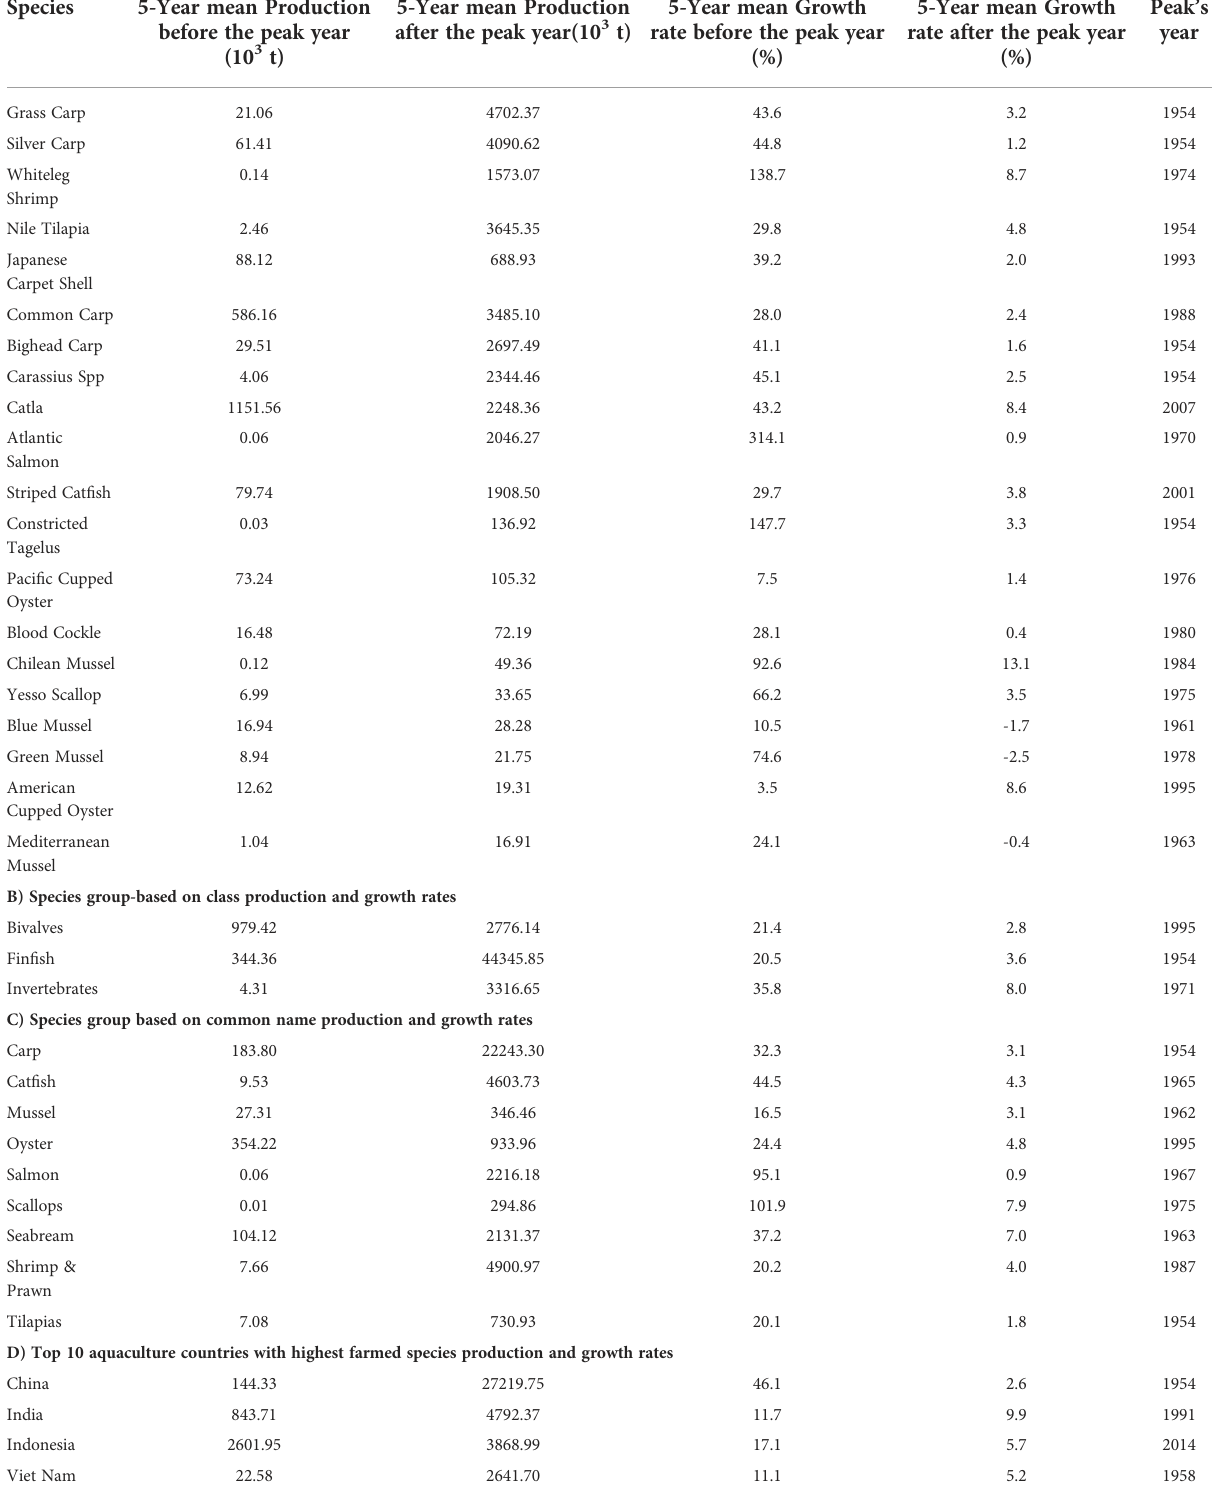
TABLE 2 Aquaculture production and growth rates: 5-year mean production and growth rates before and after the peak year. A) Farmed species production and growth